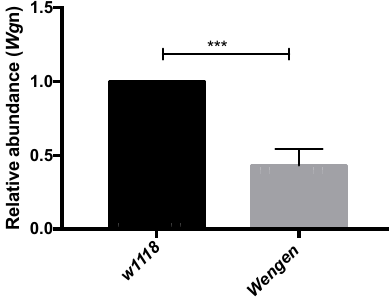
Figure A2. Validation of Wengen -RNAi line. Relative transcript levels of Wengen ( Wgn ) were measured in larval progeny of w 1118 and Wgn -RNAi flies crossed with Actin-Gal4 individuals. Transcript levels are represented relative to housekeeping gene RpL32 , and as a ratio compared to the progeny from the control cross. Values represent means from three replicates and error bar represents standard deviation. Data analysis was performed using unpaired t -test using GraphPad Prism 7 software. *** p < 0.001.